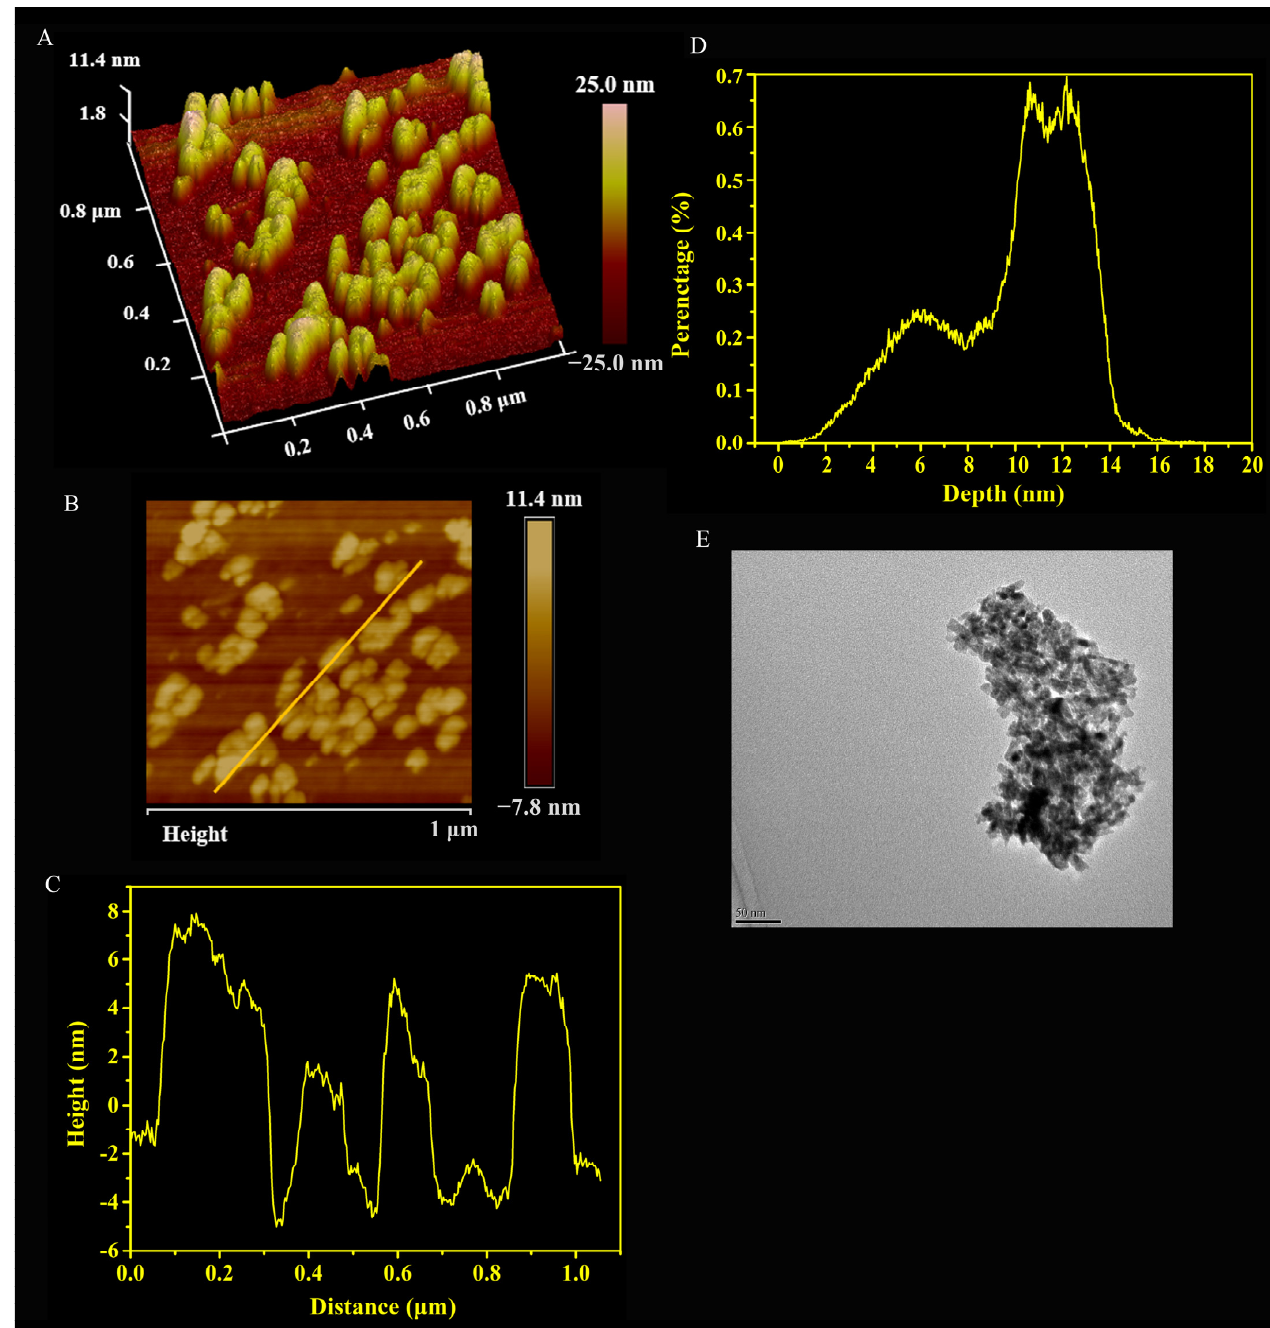
Figure 2. Characterization of Arg-CS by atomic force microscopy and transmission electron microscopy. ( A ) the 3D image of AFM, ( B ) the two-dimensional image of AFM, ( C ) the height distribu- tion of Arg-CS along the line in ( B ), and ( D ) the height distribution of all the Arg-CS shown in ( B ). The representative TEM image of Arg-CS ( E